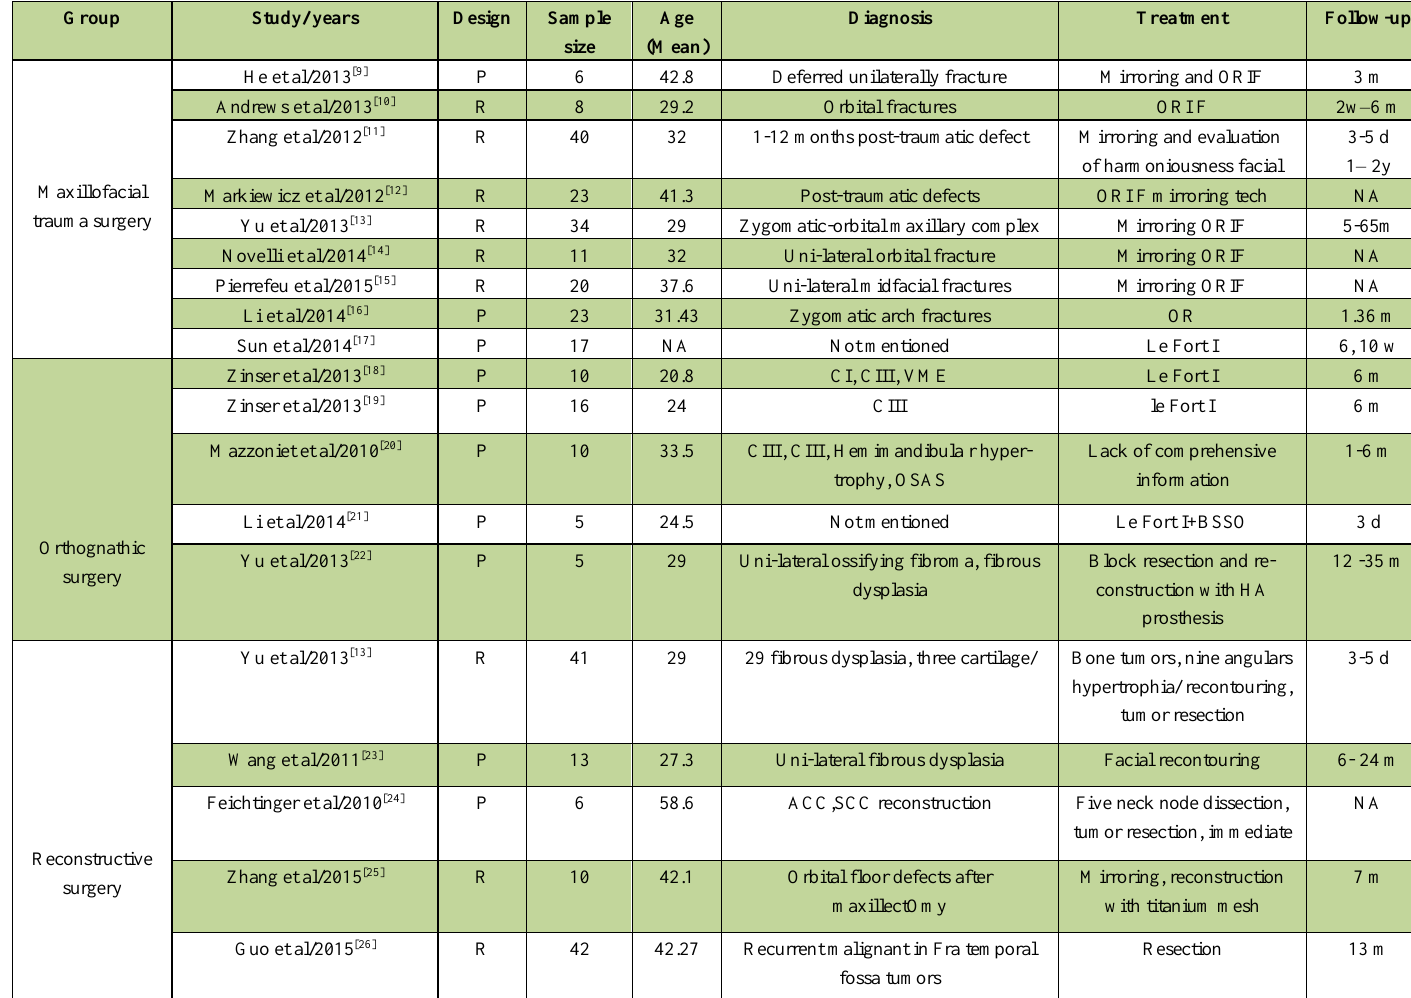
Figure 1. Study Attrition Diagram. Table 1. Studies selected for systematic review and meta-analysis.